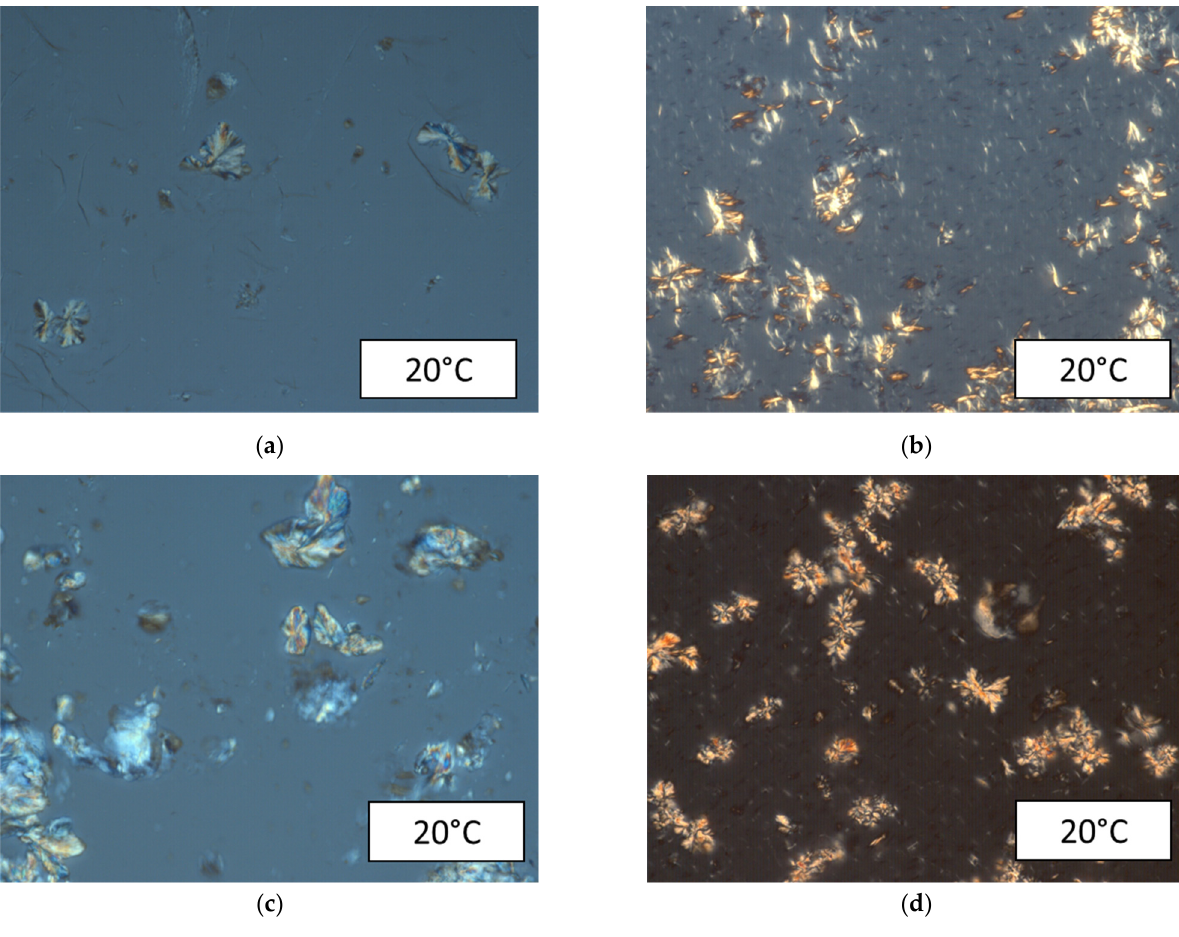
Figure 4. CPM images at 20 °C of oils ( a ) 2-PI2, ( b ) 3-PI2, ( c ) 2-PI3, and ( d ) 3-PI3. Wax crystals were not observed for oils 1-PI2 or 1-PI3 under the same conditions. not observed for oils 1-PI2 or 1-PI3 under the same